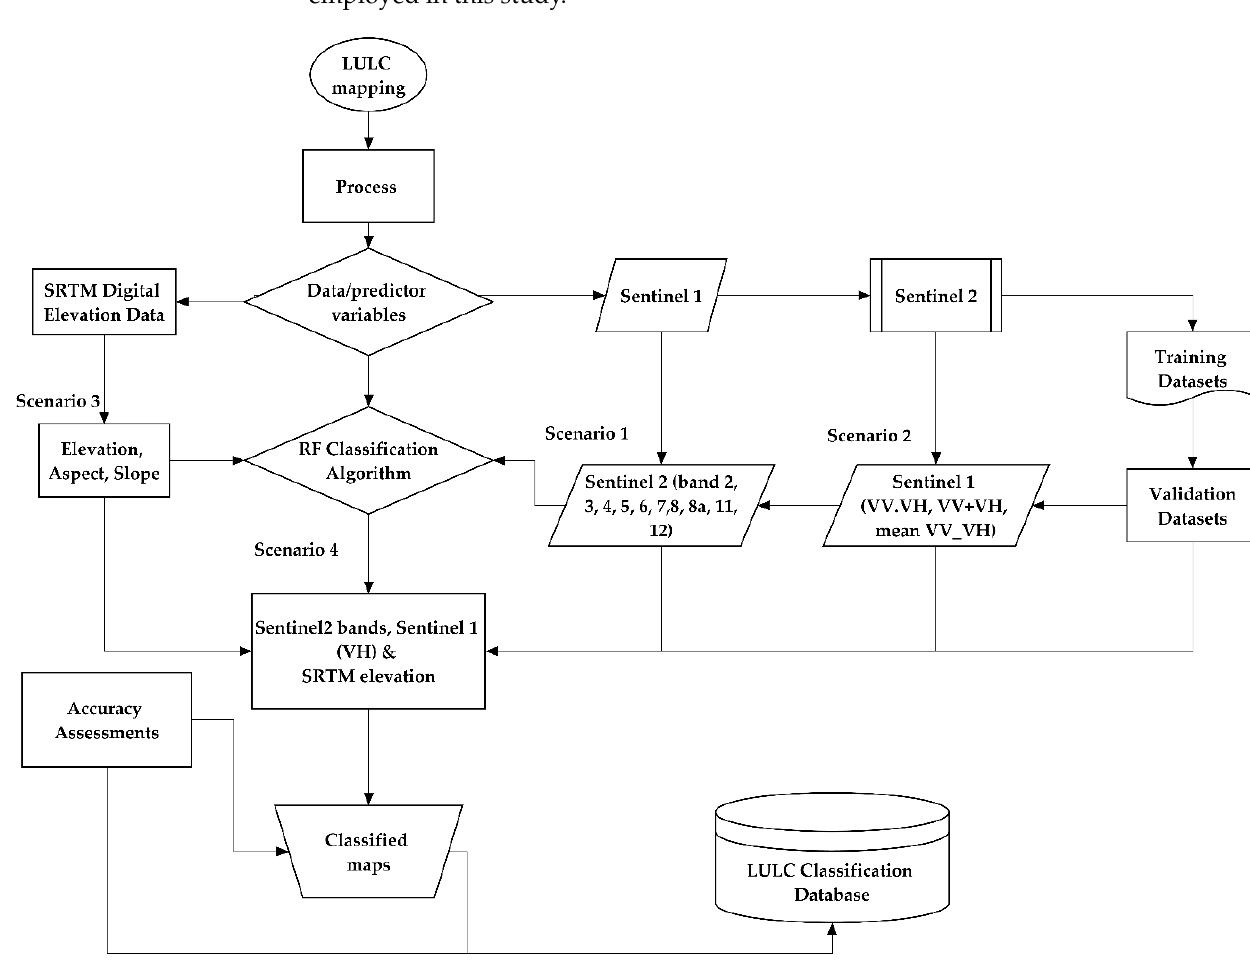
Figure 2. The workflow of the processes and approaches implemented in the